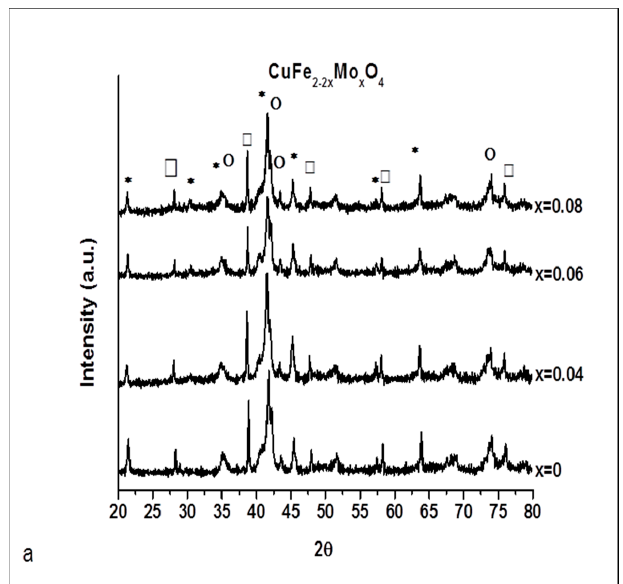
Figure 1. Patterns of the molybdenum doped copper ferrites: *–CuFe 2 O 4 ,